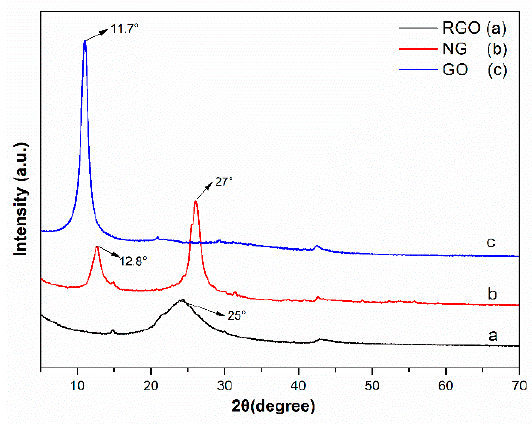
Figure 4. XRD pattern of GO, NG, and RGO fillers.